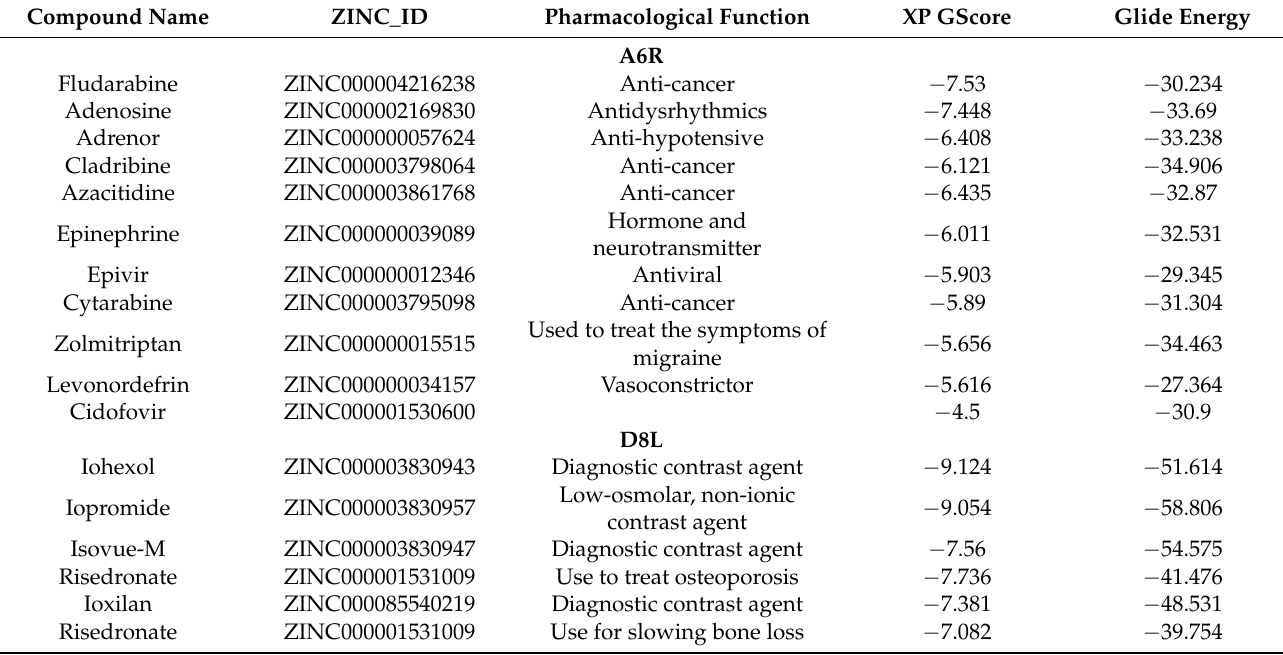
Figure 3. Image of 3D ( A ) and 2D ( B ) interactions of ligands and proteins during the XP docking process. The 3D structures show the binding pocket of the proteins including the positioning of the ligands; the binding pocket colors in the 3D plots correspond to residues’ hydrophobicity, while the colors in the 2D plots correspond to different types of bonds. ( A1 , B1 ) complex of A6R and Fludarabine, ( A2 , B2 ) complex of D8L and Fludarabine, ( A3 , B3 ) complex of F13L and Fludarabine. Table 1. Extra-precision (XP) docking score of the best